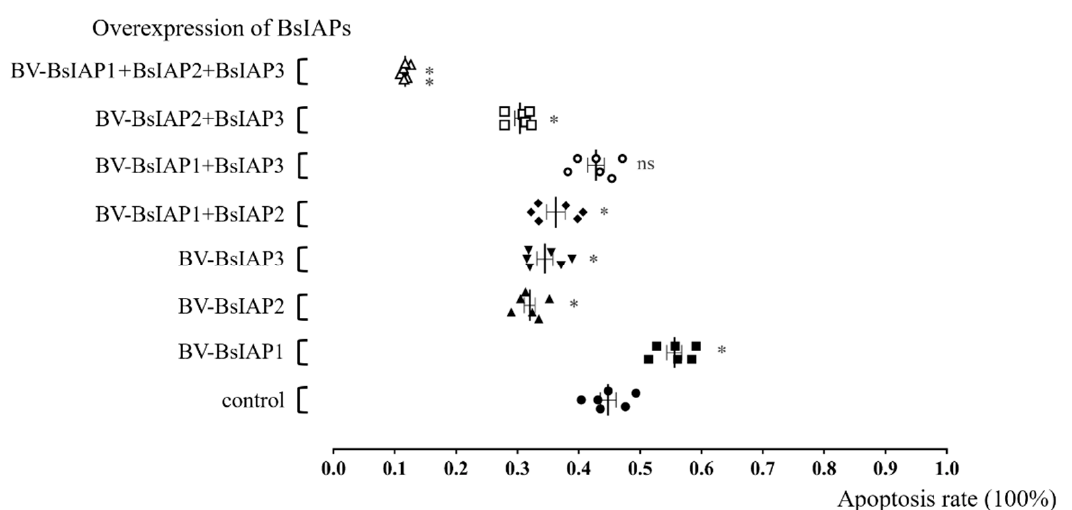
Figure 7. Effects of overexpression of BsIAPs on Sf9 cell apoptosis rate. * p < 0.05, ** p < 0.01. After Sf9 cells were infected with recombinant baculovirus stably expressing BsIAPs for 48 h, the apoptosis rate was determined by flow cytometry. Control cells were infected with BV-gfp under the same operation.